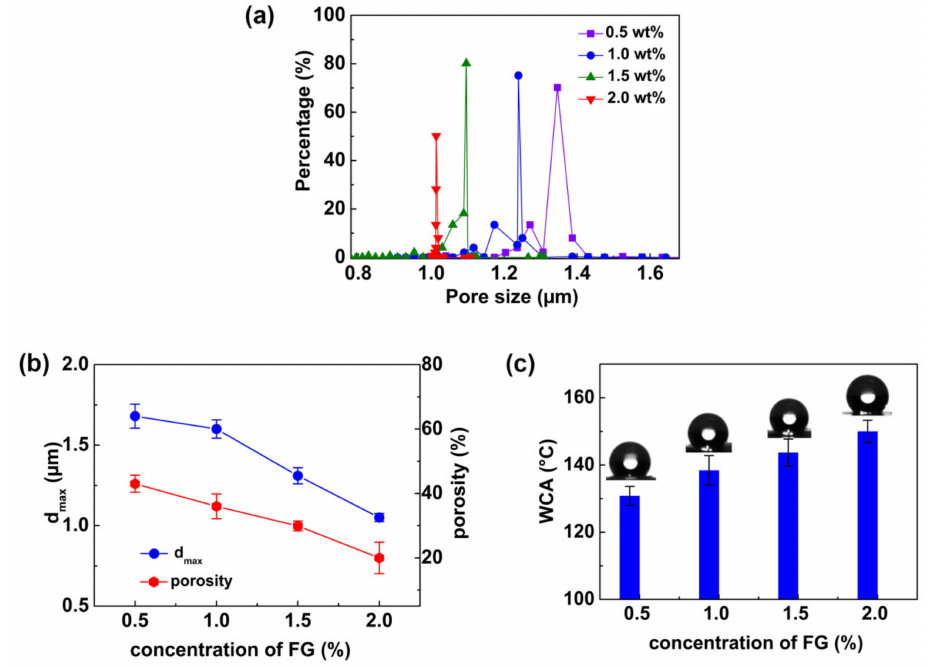
Figure 3. ( a ) Pore size distribution, ( b ) d max and porosity, ( c ) and contact angle of PU / FPU / TPU-50 / FG nanofiber WB fabrics at di ff erent FG